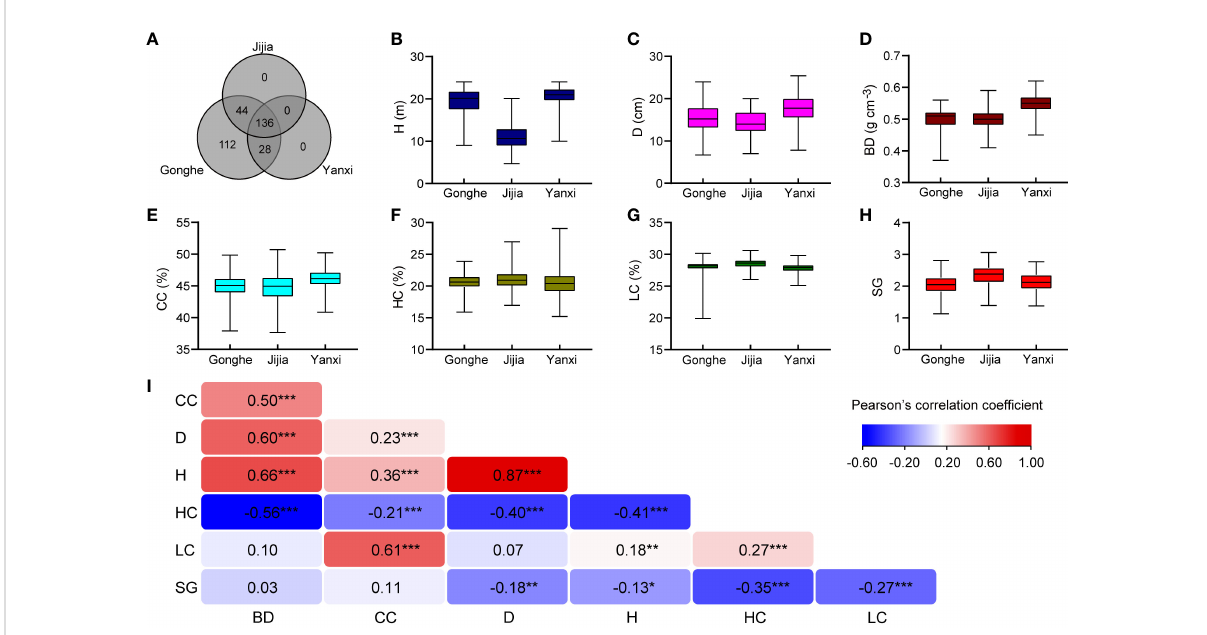
FIGURE 1 Phenotypic data summary. (A) The distribution of clonal progenies among three sites. Boxplots (phenotypic data) of H (B) , D (C) , BD (D) , CC (E) , HC (F) , LC (G) , SG (H) of E . urophylla × tereticornis hybrids from Gonghe, Jijia and Yanxi. (I) Pearson ’ correlation ( r ) coef fi cients between across-sites genotype best linear unbiased predictions (BLUPs) for pairs of traits and signi fi cance of two-sided test (***, ** and * are P < 0.001, P < 0.01 and P <0.05). BLUPs for each genotype, shown as bar plots in Figure S1, are given as deviations from the grand mean for each trait (Table